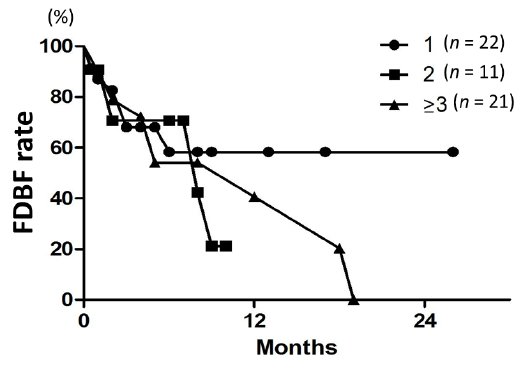
Figure 4. FDBF curves according to the tumor number (1, 2, or >3) in all 54 patients. There was no difference among the three groups ( p =